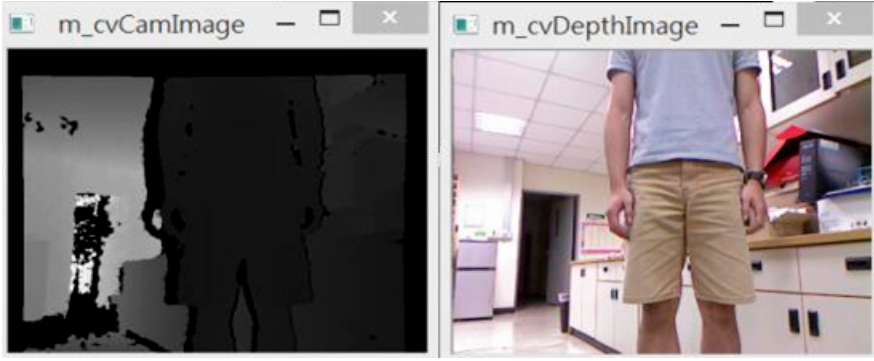
Figure 3. Example of depth map vs. standard camera image.